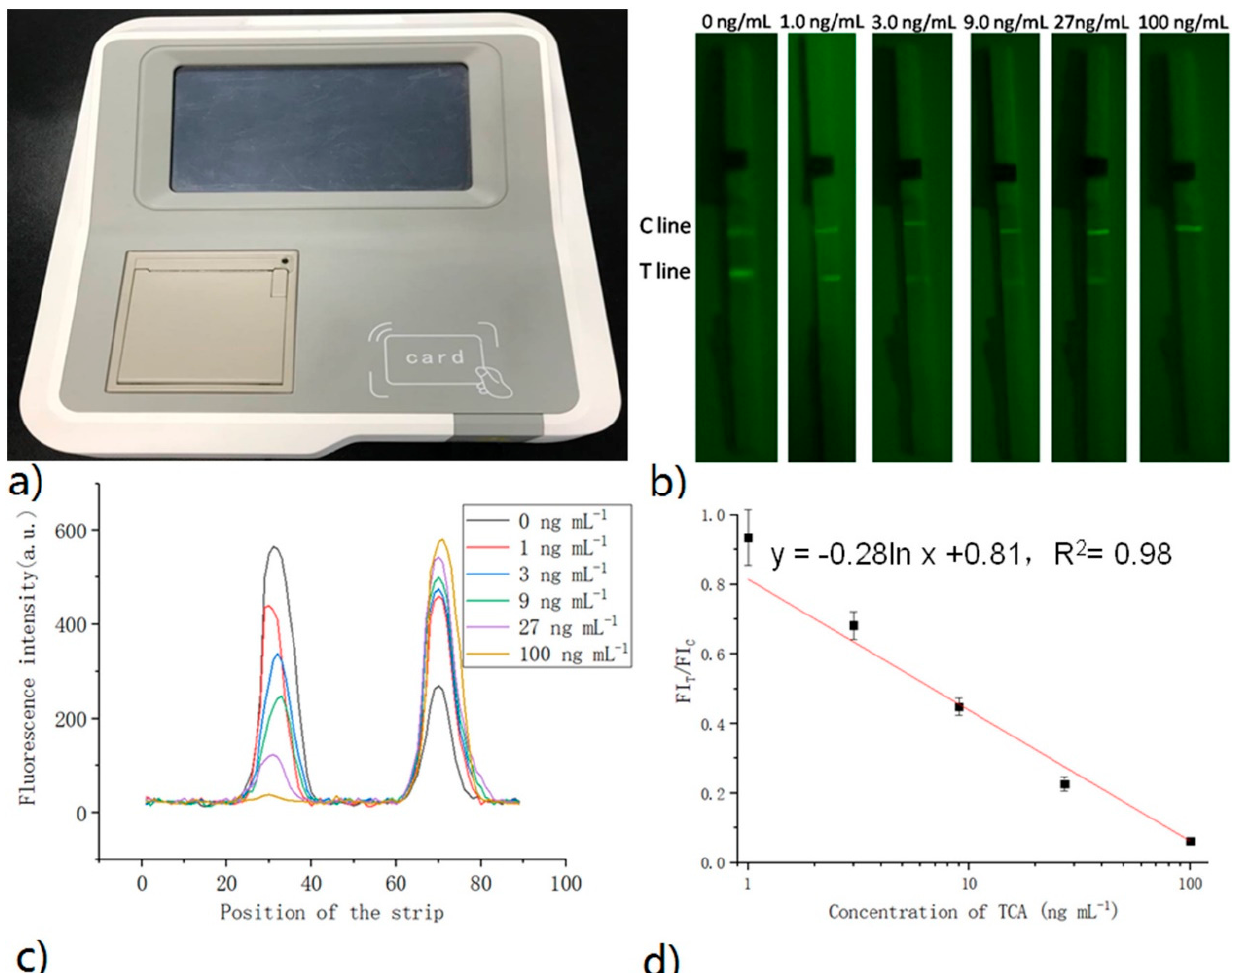
Figure 3. ( a ) The compact reader used for the detection of luminescent up-conversion nanoparticles. ( b ) The UCNPs-ICA at different TCA levels measured using a fluorescence camera. ( c ) Peaks of UCNPs-ICA at different TCA concentrations measured exploiting a luminescent up-conversion detector. The signal is expressed in terms of fluorescence intensity with respect to the position along the strip; thus, the peaks are relative to the areas corresponding to the T line (first peak) and the C line (second peak). ( d ) Calibration curve determined for the UCNPs-ICA, with different concentrations of TCA. Each value is calculated as the mean of 3 replicates. Reprinted from Ref. [41], copyright 2019, with permission from Elsevier.